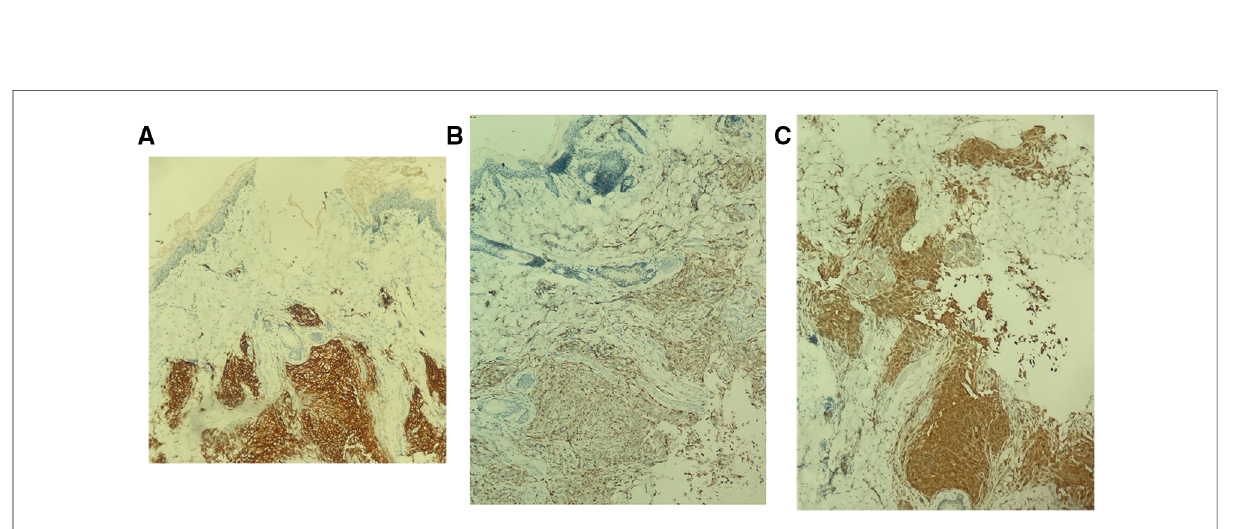
FIGURE 3 Immunohistochemistry. The lesional histocytes are diffusely positive for CD1a ( A ), CD68 ( B ), and S100 ( C